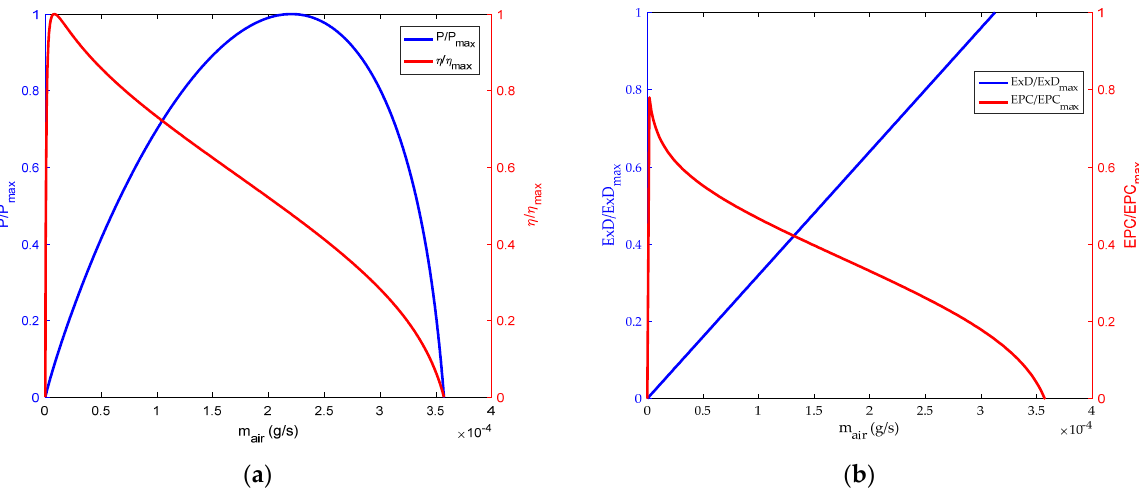
Figure 5. Influence of air flow rate. ( a ) power density and energy efficiency; ( b ) exergy destruction rate and exergetic performance coefficient.